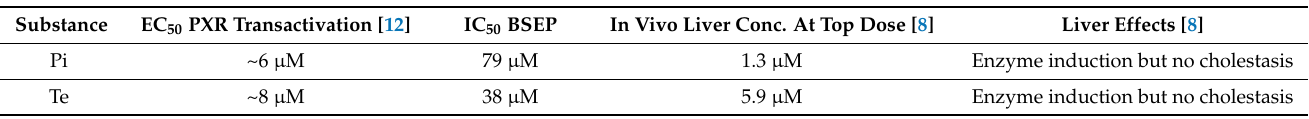
Table 2. Concentrations of Pi and Te found to activate the pregnane-X-receptor (PXR) responsible for enzyme induction, to inhibit the bile salt export pump (BSEP) responsible for induction of cholestasis, measured in vivo concentrations, and observed in vivo effects.